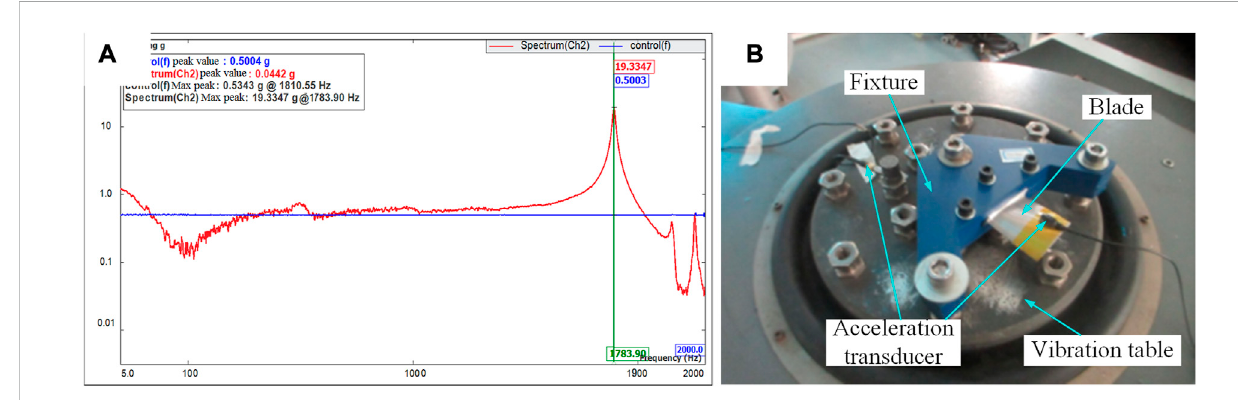
FIGURE 2 (A) Sweep frequency response curve and (B) schematic diagram of vibration